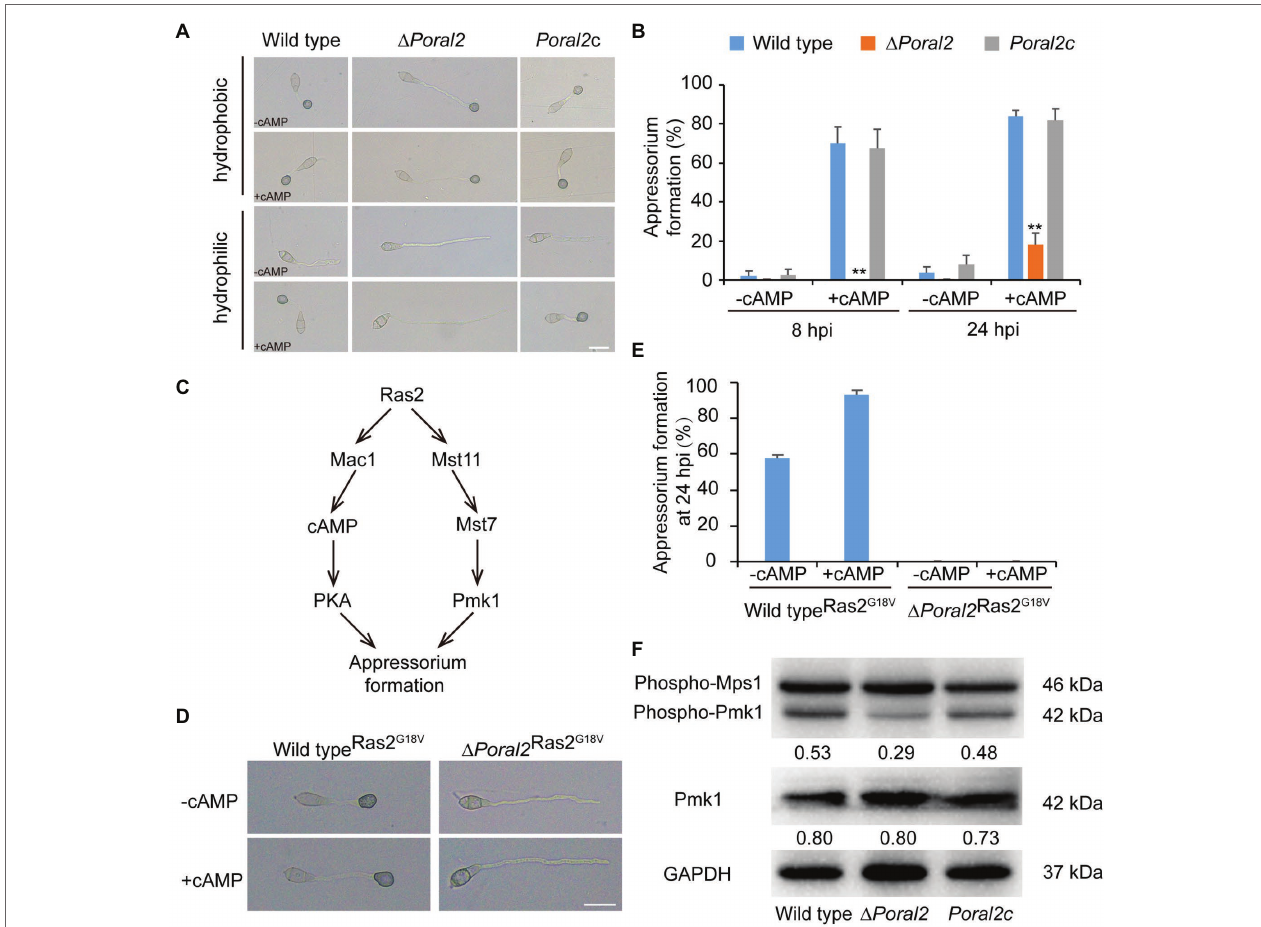
FIGURE 4 | Defects of ∆ Poral2 in the cAMP-PKA and Pmk1 MAPK signaling pathways. (A) Appressorium formation of P. oryzae strains on hydrophobic or hydrophilic surfaces with or without supplemented 10 mM 8-Br-cAMP at 24 hpi. Bar = 20 μ m. (B) Appressorium formation rate (%) of P. oryzae strains on hydrophobic and hydrophilic surfaces with or without supplemented 10 mM 8-Br-cAMP at 8 and 24 hpi. Conidial suspensions were dropped onto GelBond film and incubated at 22 ° C. Significant differences compared with the wild type were estimated by Tukey’s HSD test: ** p < 0.01. (C) Regulatory relations between Ras2 and the cAMP-PKA pathway and Pmk1 MAPK pathway. (D,E) Appressorium formation of P. oryzae strains on hydrophilic surfaces with or without supplemented 8-Br- cAMP when RAS2 G18V was overexpressed in both the wild-type and ∆ Poral2 strains. Bar = 20 μ m. (F) Expression levels of Mps1 and Pmk1 kinases was detected by Western blot using anti-Phospho-p44/42 MAPK antibody (top panel), anti-ERK1/ERK2 MAPK antibody (middle panel), and anti-GAPDH antibody (lower panel). Numbers under the pictures represent the protein contents of phospho-Pmk1 or total Pmk1 relative to that of GAPDH (mean, n = 3 independent experiments). The protein contents were determined according to gray values of Western blot bands measured by Image J. The phosphorylation level of Pmk1 in the ∆ Poral2 mutant was reduced compared to the wild